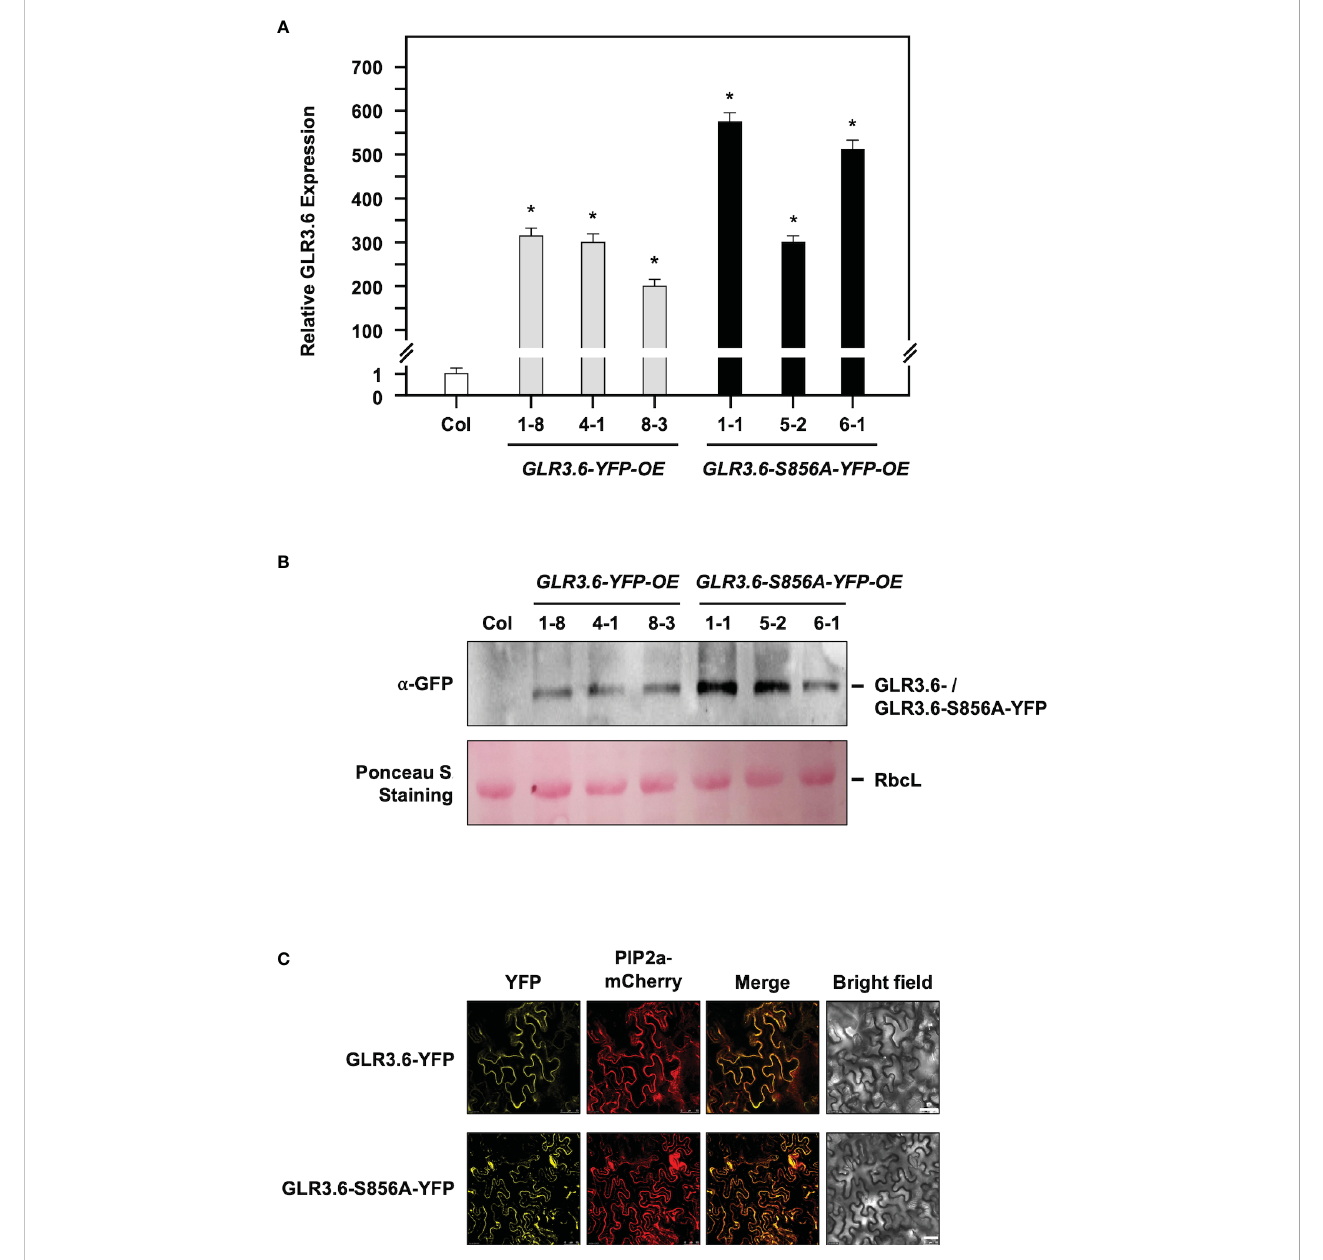
FIGURE 8 Characterization of YFP-fussed GLR3.6- and GLR3.6-S856A-overexpression lines. (A, B) Seven-day-old seedlings were used for GLR3.6 accumulation assay, which was analyzed using q-PCR and western blotting. Antibodies against a -GFP were used for protein accumulation assay. The ribulose bisphosphate carboxylase large subunit stained using Ponceau S was used as loading control. (C) Subcellular localization of the YFP-fused GLR3.6 and GLR3.6-S856A was found to be completely localized to the plasma membrane using transient expression assay. Scale bars = 50 m m. The data are presented as mean values ± SD. N = 3. The asterisks (*) indicate signi fi cant differences between samples (P < 0.05, student's t test). ACTIN2 was used as the input control for transcript level normalization. m